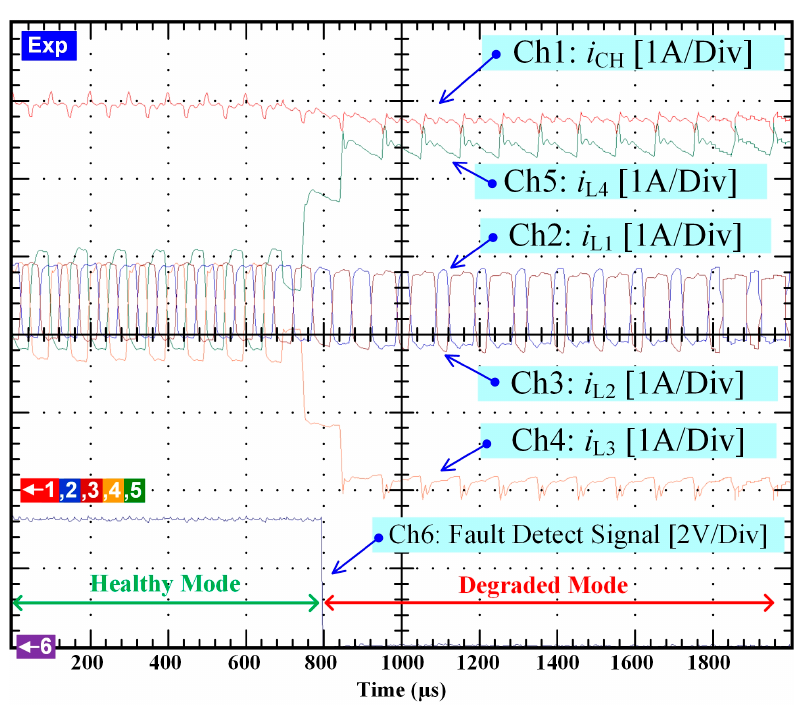
Figure 14. Obtained experimental results showing the transient and accommodation after fault.